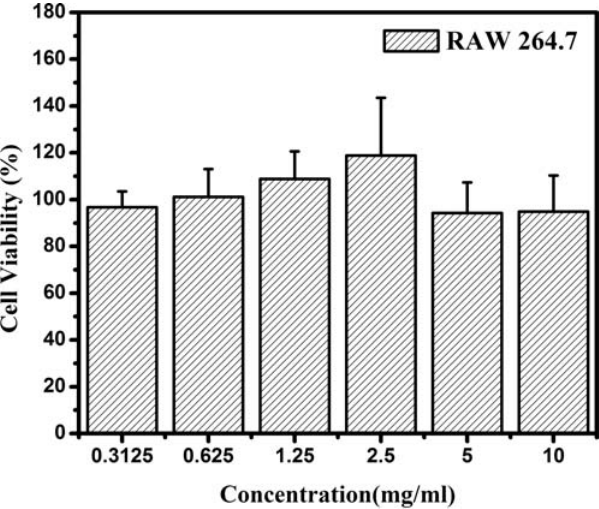
Fig. 3. Cytotoxicity study of folate modi¯ed micelles against RAW 264.7 cells.